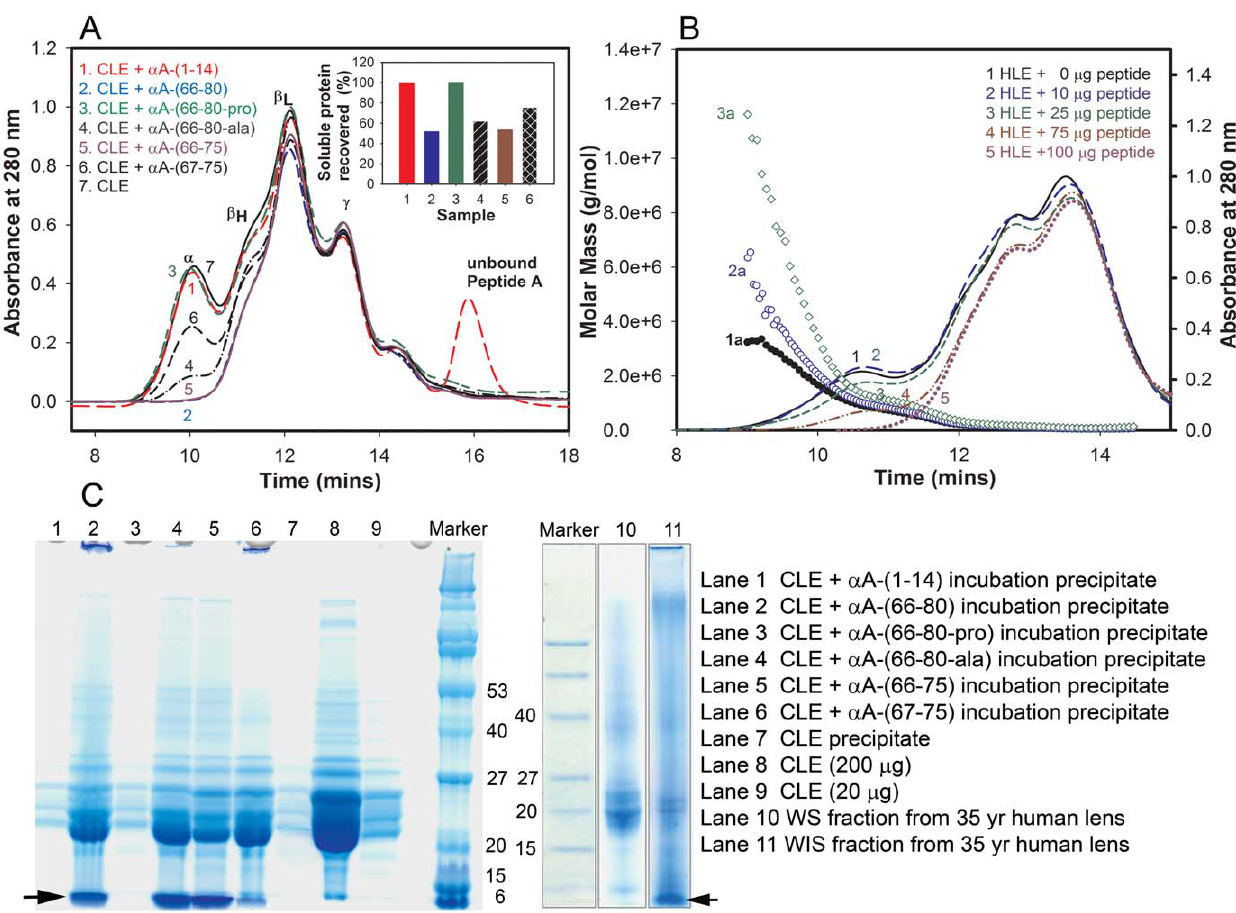
Figure 2. The a A-(66-80) peptide–induced aggregation and precipitation of crystallins. (A) Size-exclusion column elution profiles of soluble crystallins from WS CLE (200 m g) following incubation with or without different synthetic peptides (100 m g) for 16 hrs at 37 u C. The chromatography was performed using a TSK G5000PW XL column (7.8 mm 6 30 cm) and the elution was monitored using a 280 nm absorption detector. The inset in the figure shows the amount of soluble protein recovered after peptide treatment and centrifugation at 3000 rpm for 10 min. Samples 1-7 in the inset correspond to samples 1-7 analyzed by the size-exclusion column. The results show that the effect of a A-(66-80) peptide is sequence specific. The addition of a A-(66-80), a A-(66-75) and a A-(67-75) peptides, present in human lens WIS fractions, causes precipitation of crystallins when incubated with CLE. (B) Effect of the peptide on 35-year-old human lens crystallins. HLE (190 m g) was incubated with various amounts of synthetic a A-(66-80) peptide for 16 h at 37 u C. The samples were centrifuged, and the supernatants were chromatographed on a TSK G5000PW XL column connected to a multi-angle light scattering instrument (Wyatt Technology). Lines 1a, 2a and 3a show the distribution of molecular mass across the UV profile of samples 1, 2 and 3, respectively. Mass profiles of samples 4 and 5 could not be analyzed due to instrument limitations. The results show that the presence of increased amounts of a A-(66-80) peptide in the incubation mixture leads to increased aggregation, light scattering and precipitation. (C) SDS-PAGE analysis of precipitates of CLE and a A-derived peptides or substituted a A-peptides from panel A and the WS and WIS fractions from a 35-year-old human lens. The left arrow on lane 1 points to the precipitation of test peptides with crystallins and the right arrow on lane 11 points to the presence of peptides in human WIS fraction. The results of SDS-PAGE analysis show the precipitate formed